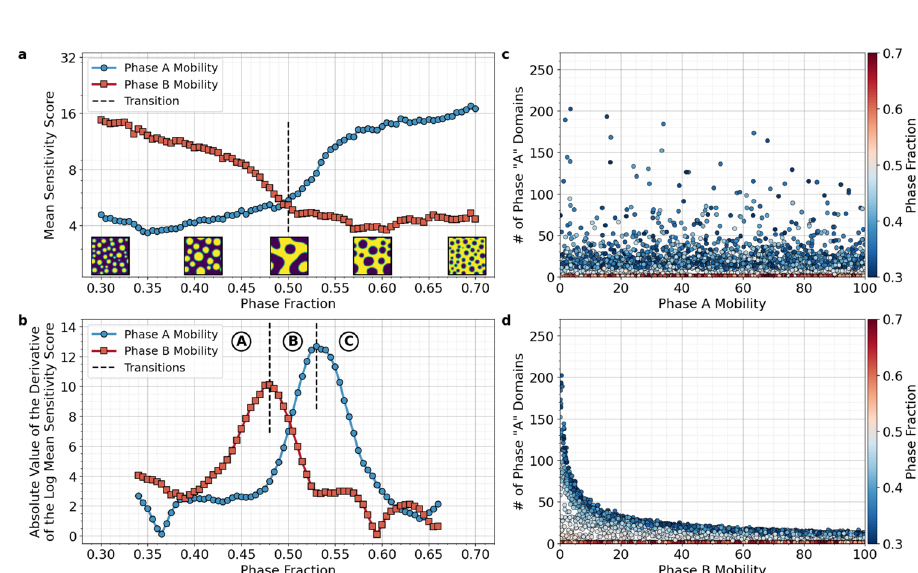
Fig. 4 Predicting the process parameters for spinodal deposition of a two-phase mixture. a Mean sensitivity score for predicting mobilities as a function of phase fraction. When changing the phase fraction from low to high, the dominant role of the phase mobility switches from B to A. The dashed line indicated the expected transition from a A-rich patterns regime to a B-rich patterns regime. Insets depict example realizations for particular values of the phase fraction order parameter. For the microstructure insets, yellow denotes phase A, and purple phase B. b Variation (derivative) of the sensitivity score as a function of phase fraction. c , d Scatterplots of the variability on the number of phase domains A as a function of the phase A and B mobilities